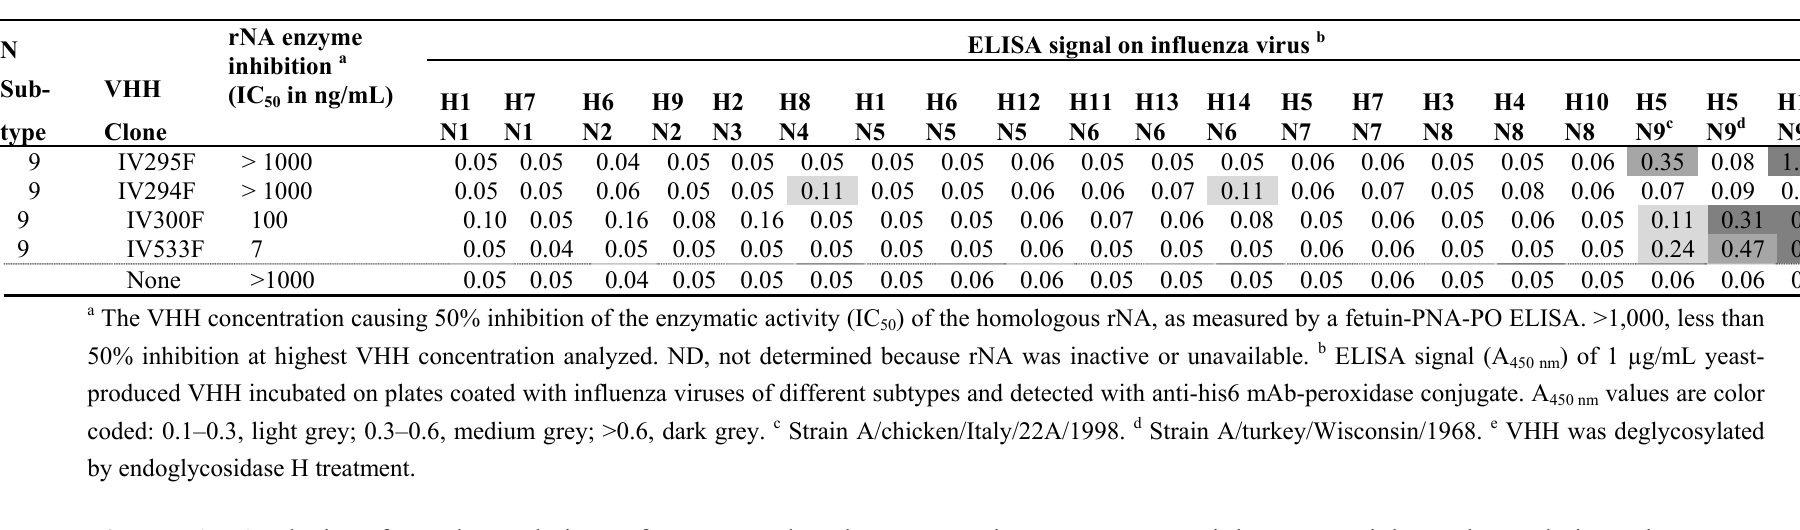
Figure 1. Analysis of N-glycosylation of yeast-produced VHHs. Five VHHs containing potential N-glycosylation sites were deglycosylated by endoglycosidase H treatment (+) or mock-incubated ( − ) prior to analysis by reducing SDS-PAGE. The position of relevant molecular mass markers (Benchmark TM protein ladder, Invitrogen) is indicated on the